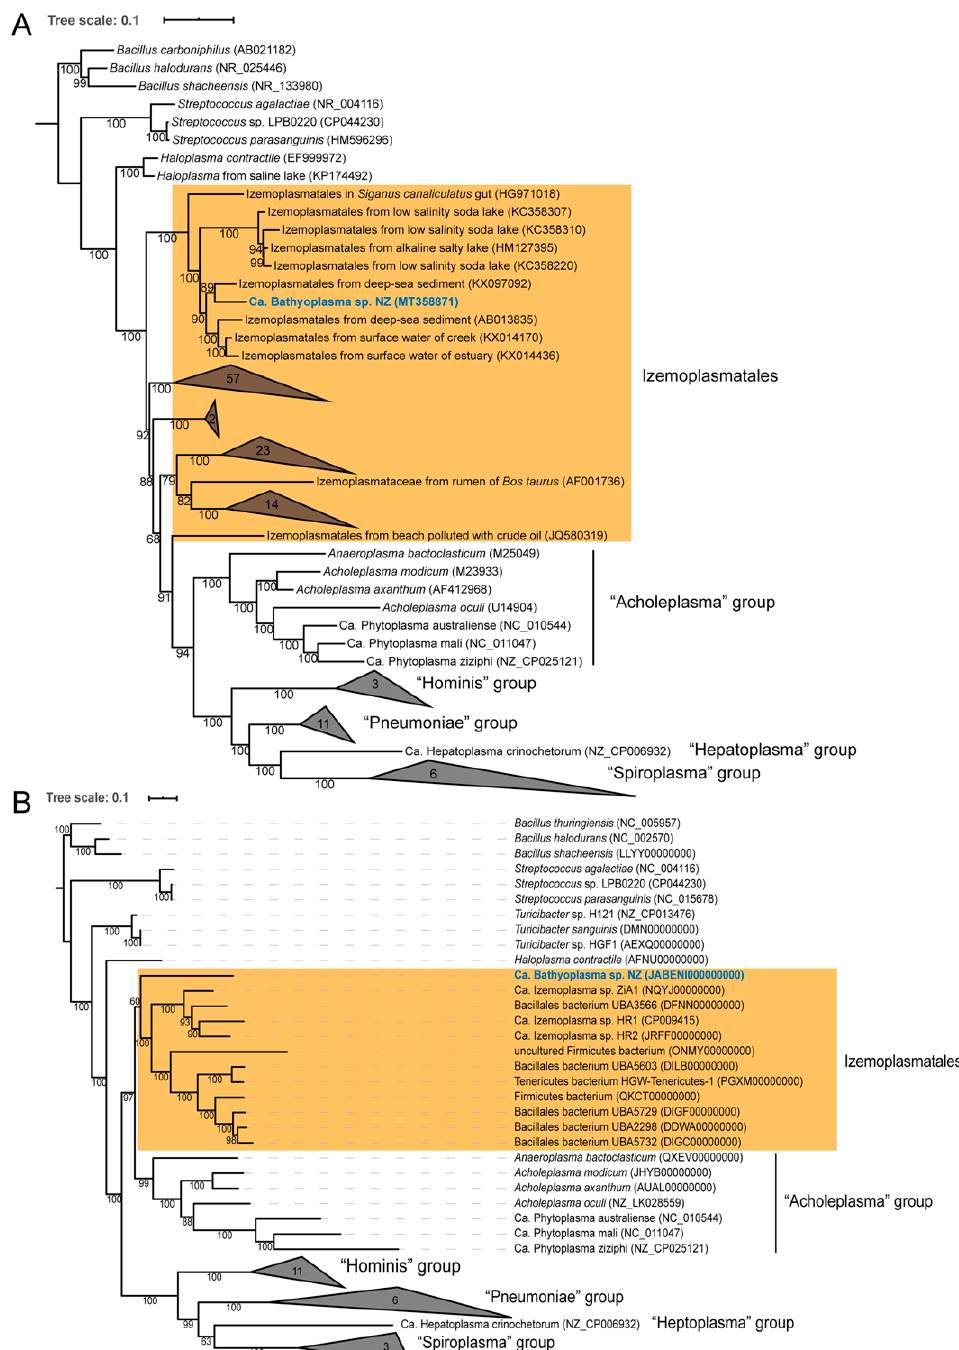
Figure 2. Maximum-likelihood phylogenetic tree based on ( A ) 16S rRNA genes and ( B ) 21 concatenated conserved proteins. Three Bacillus (Firmicutes) bacteria are used as outgroups. The species in bold blue comes from this study. Bacteria belonging to the Izemoplasmatales order are masked by orange background. Bootstrap values are indicated on the branches, and accession numbers are labeled in parentheses. The species number in each collapsed node is also labeled. The tree scale bar represents the number of expected substitutions per site.